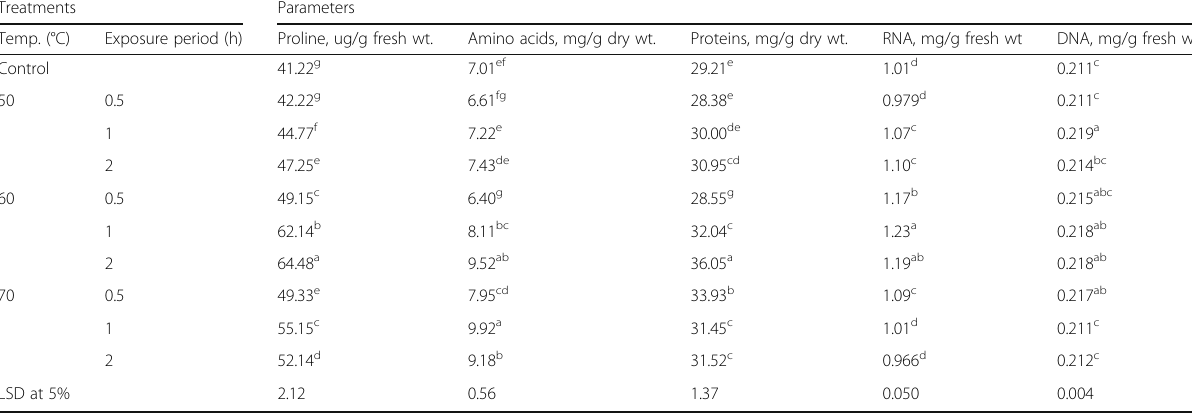
Table 6 Effect of seed hardening on proline, free amino acids, RNA and DNA content of plant shoots Treatments Parameters Temp. (°C) Exposure period (h) Proline, ug/g fresh wt. Amino acids, mg/g dry wt. Proteins, mg/g dry